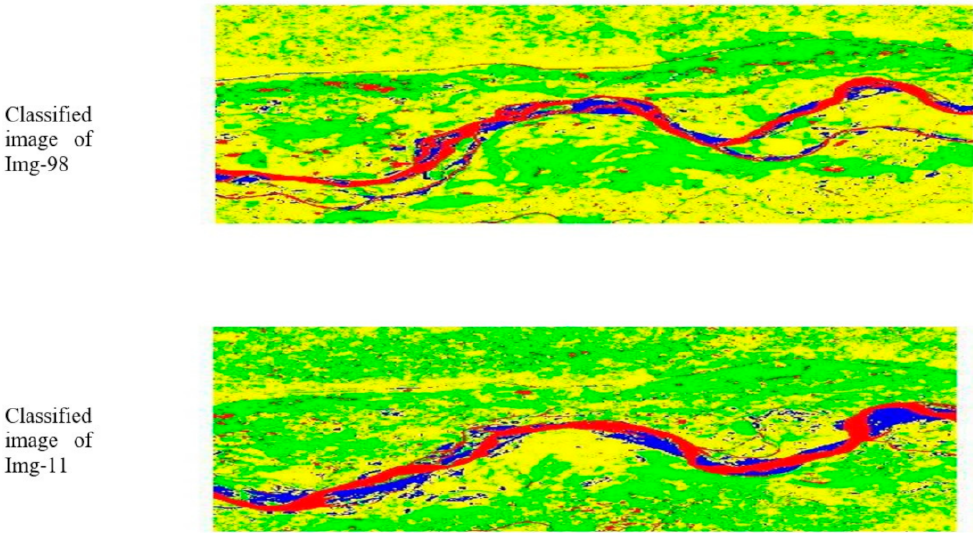
Figure 8. Result with decision tree classifier on the images of both